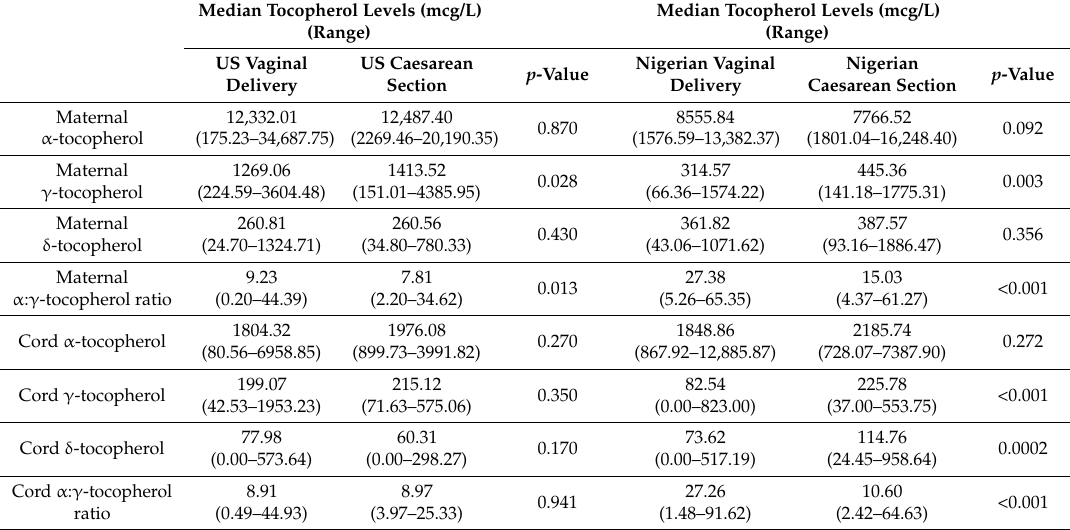
Median Tocopherol Levels (mcg/L) (Range)